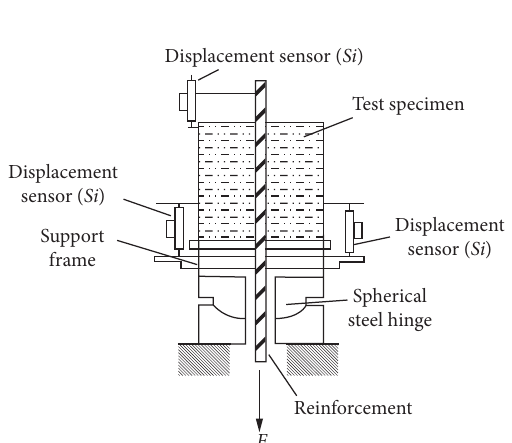
Figure 2: Central pullout test device.